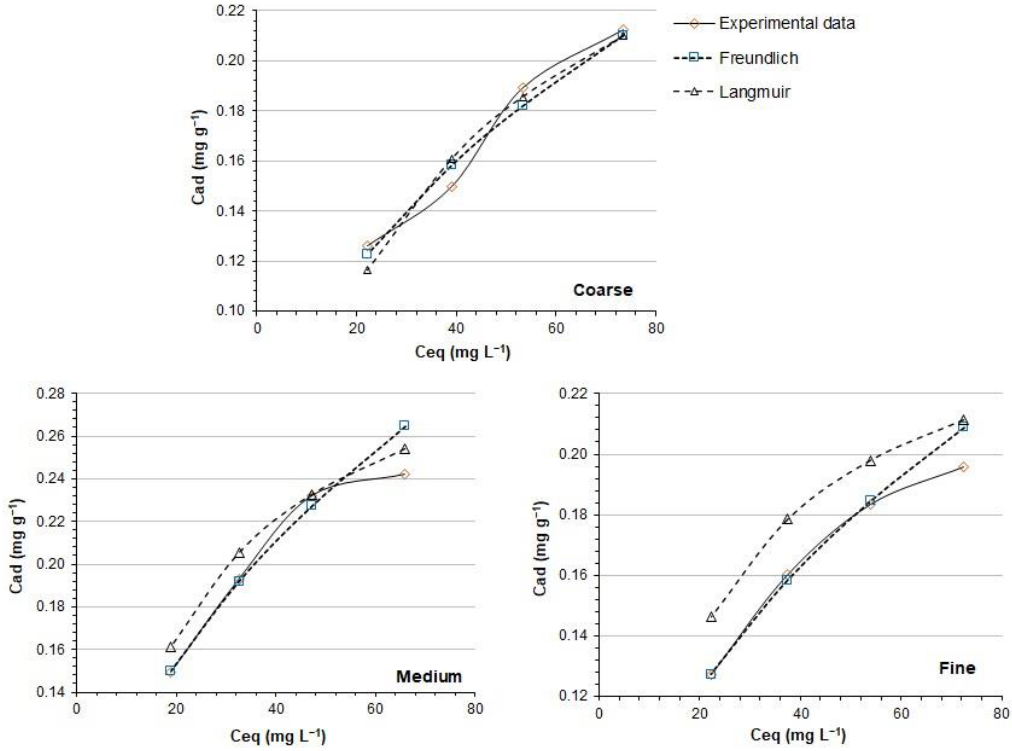
Figure 4. Adsorption isotherms for phosphate ions on adsorbent substrates prepared with the three granulometric fractions of material and activated with HCl.